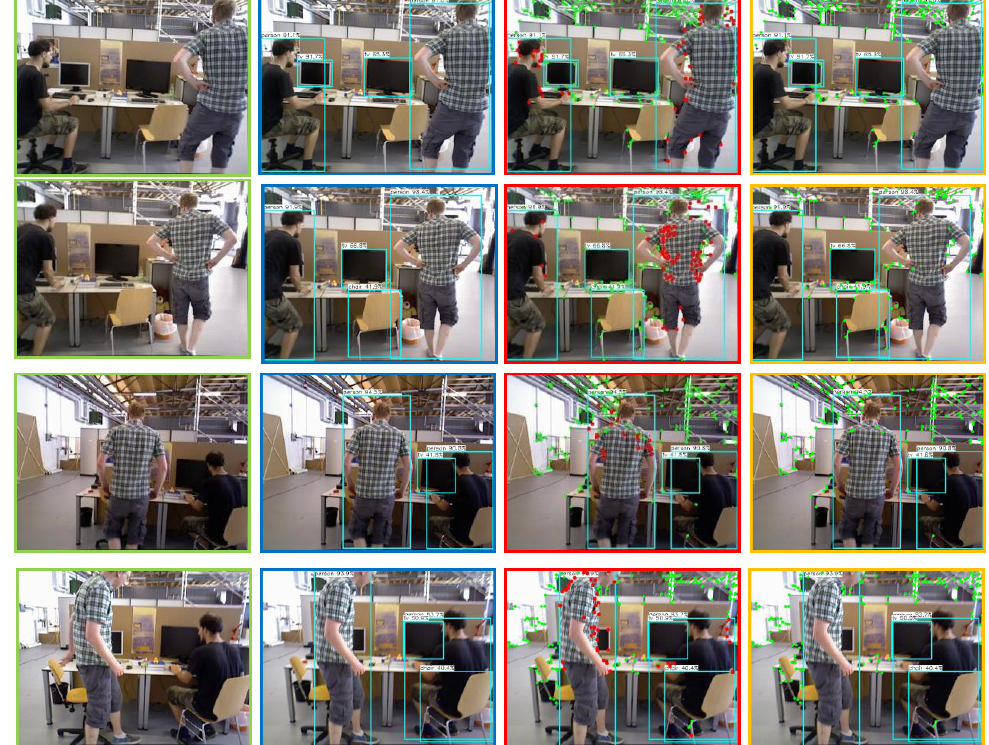
Figure 5. Dynamic point rejection, from left to right: ( a ) original image; ( b ) target detection; ( c ) dy- namic feature point detection for dynamic objects; ( d ) rejection of dynamic feature